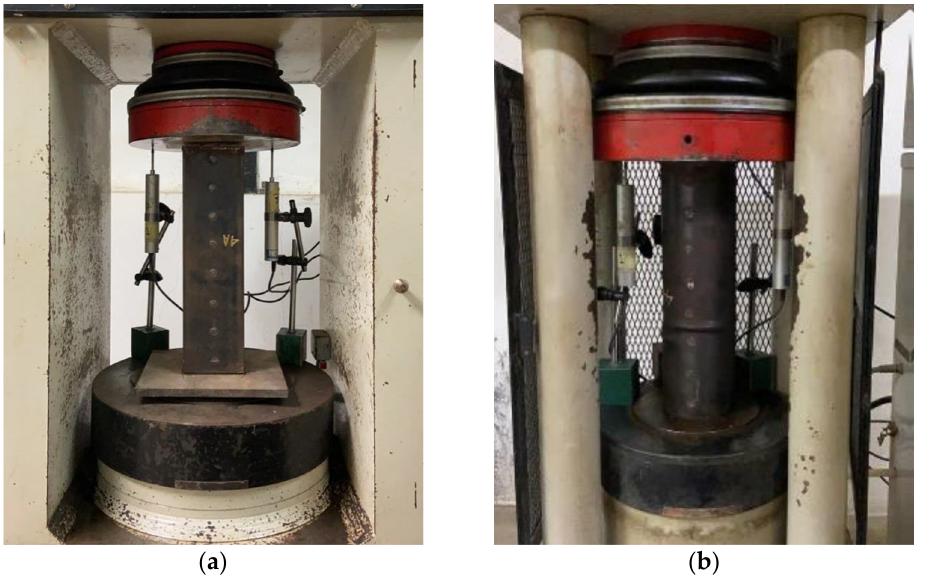
Figure 7. Experiment setup. ( a ) Typical loading for square column. ( b ) Typical loading for circular column.